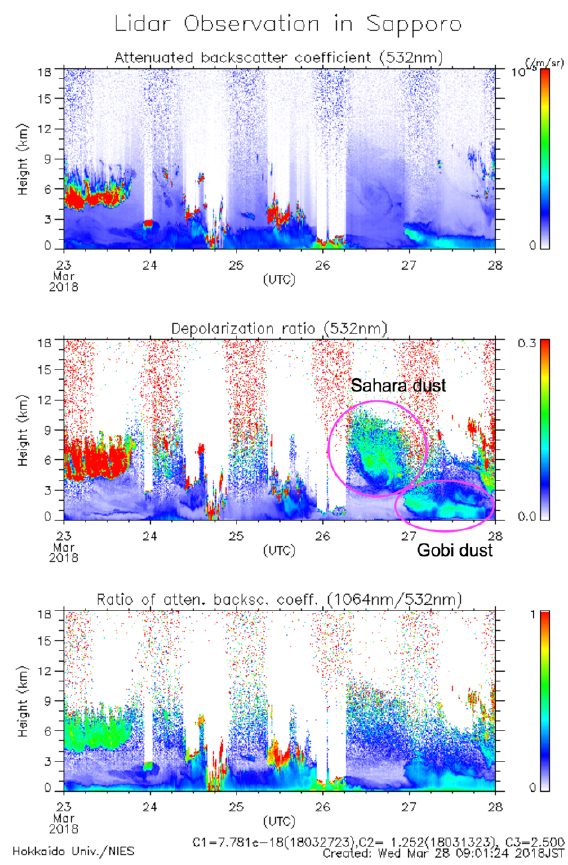
Fig.1 Time-height indications of attenuated backscatter coefficient at 532 nm (top), volume depolarization ratio at 532 nm (middle), and color ratio of attenuated backscatter coefficients at 1064 nm to 532 nm (bottom), observed in Sapporo, Japan in March 2018.